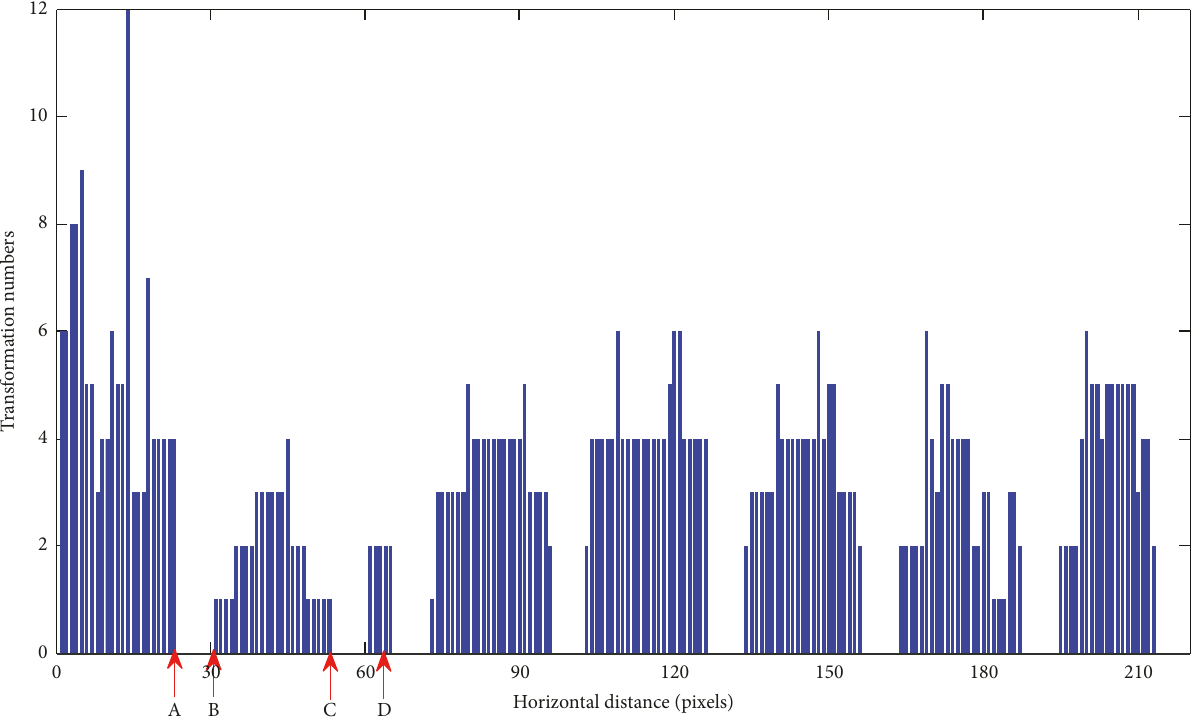
Figure 8: Histogram of transformation numbers projection.